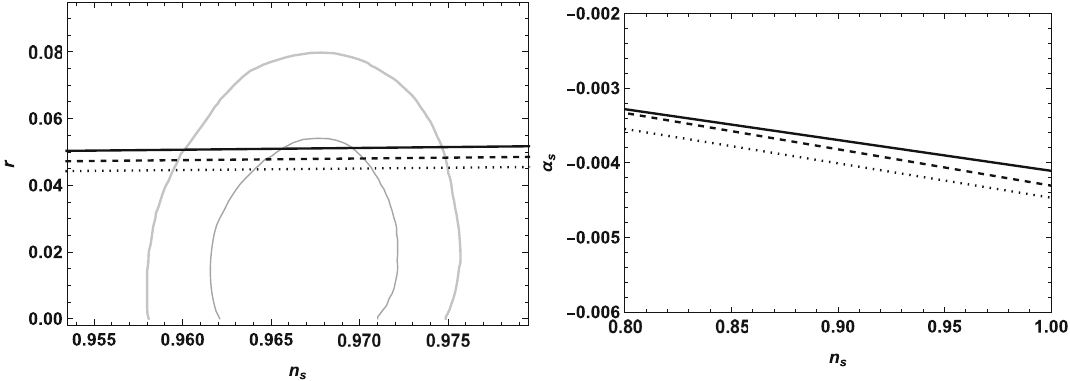
Fig. 5 Aboveplotsshowdimensionlesstemperature ϑ versustime.Leftplotisfor V (ϕ) = − ν 2 Here we fixed the σ = 0 . 76 , (cid:8) = 0 . 2 with the different values of ε , ε = 0 . 8 (solid curve), ε = 0 . 6 (dashed curve) and ε = 0 . 4 (dotted curve)